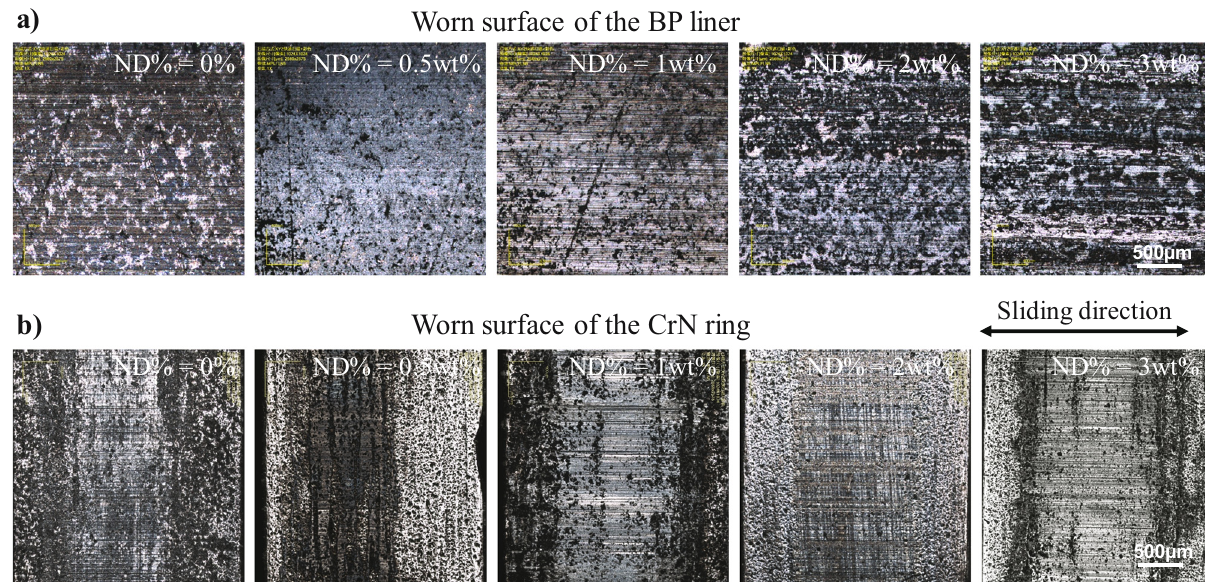
Figure 10: Worn micrographs of the BP liner ( a ) and its counterpart CrN piston ring ( b ) lubricated with di ff erent ND content lubricants.